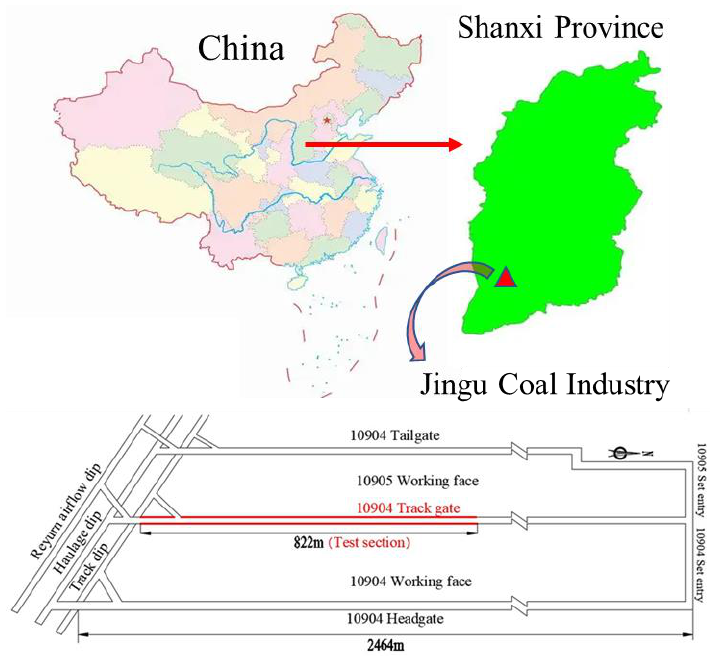
Figure 1. Coal Mine Location and Working Face Layout.